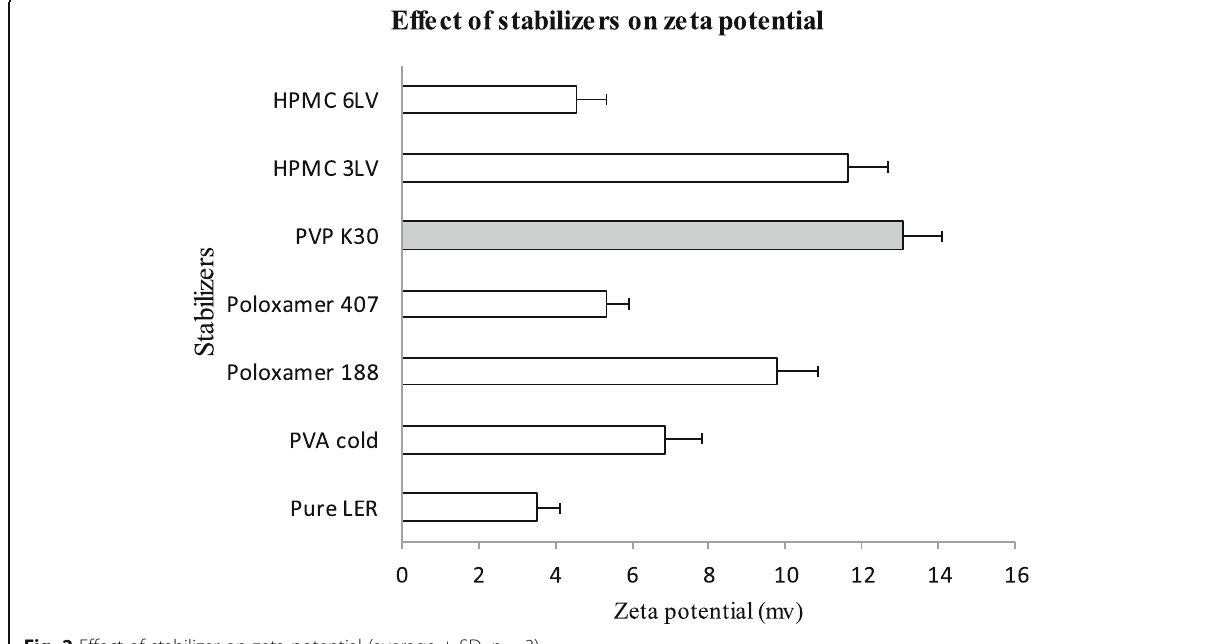
Fig. 2 Effect of stabilizer on zeta potential (average ± SD, n =